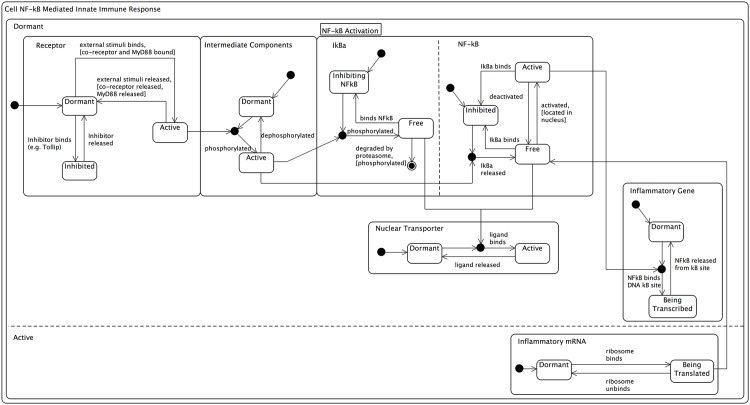
Linked state machine diagrams.Linked series of state machine diagrams for the IL-1 stimulated NF-κB signalling pathway. The individual components have their own state machines, which are explicitly linked using UML join notations and embedded within a single large state machine that represents the cell. Here the cell has two states relating to dormant or active. Developed using [41, 52, 56, 57, 66–68].